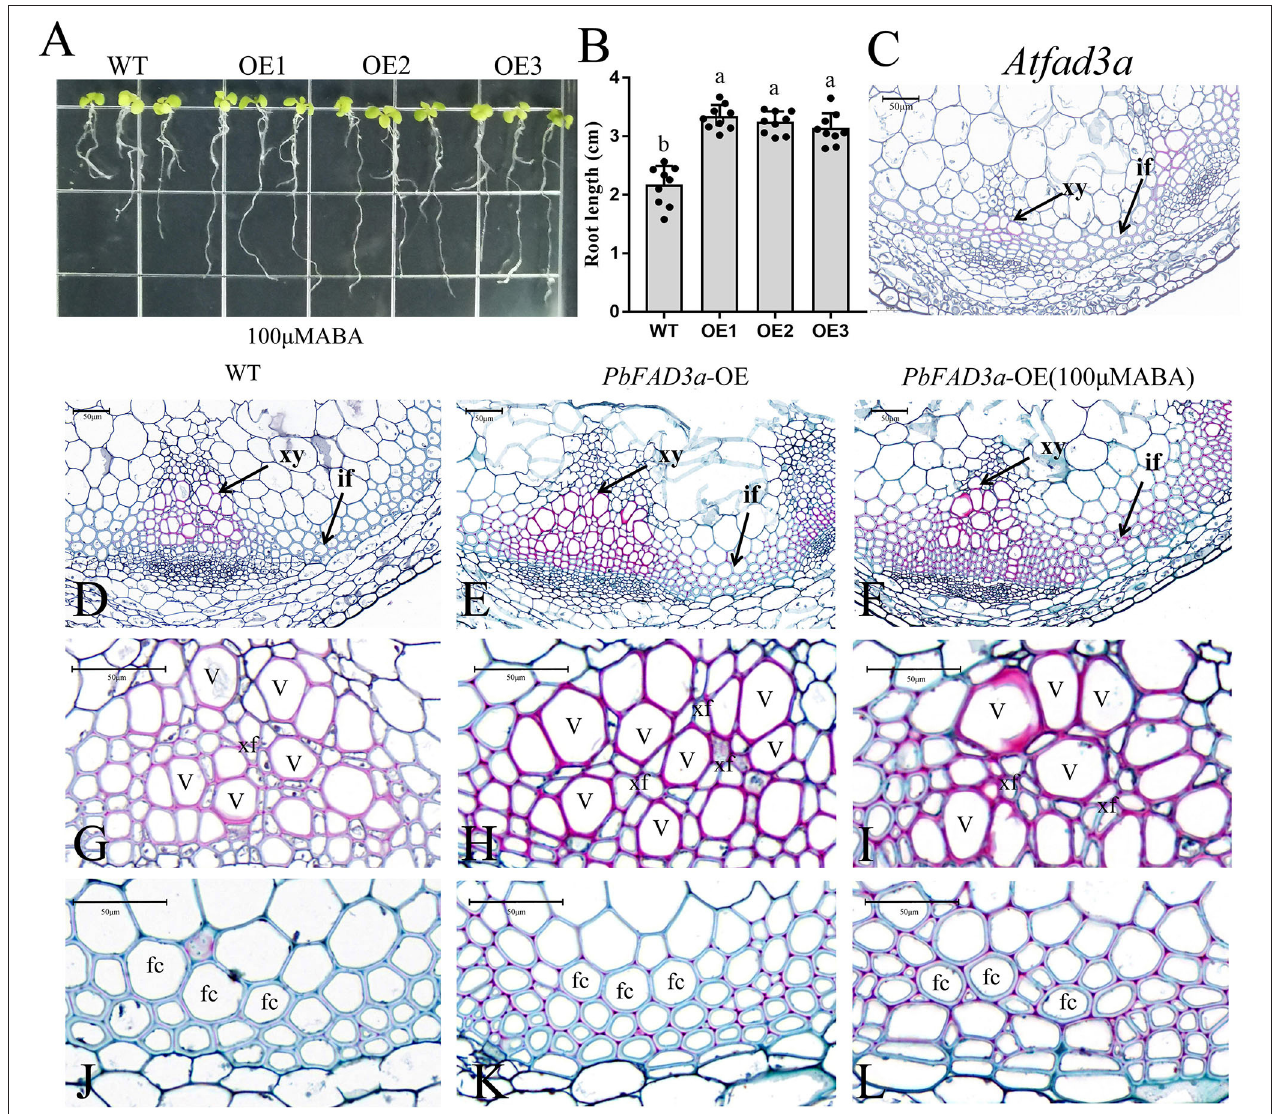
FIGURE 8 | Functional analysis of PbFAD3a in response to ABA. (A) ABA treatment of transgenic Arabidopsis seedlings. (B) Root length of PbFAD3a-transformed OE lines in response to ABA. Cross section of Arabidopsis homologous mutant of the PbFAD3a (C) , wild-type (Col-0) (D,G,J) , PbFAD3a-transformed Arabidopsis (E,H,K) , and PbFAD3a transgenic line treated with 100 µ M ABA (F,I,L) . Cross section stained with Safranin O-Fast green. The suberized, lignified, and fibrotic cell walls are stained with reddish-brown, red, and green, respectively. WT, wide-type. OE, Overexpression. If, Interfascicular fiber. Xy, Xylem. V, Vessel cell. Fc, fiber cell. Xf, Xylary fiber. The vertical bars are the means ± SD of three biological replicates and lowercase letters indicate significant differences by two-tailed Student’s t -test ( P <